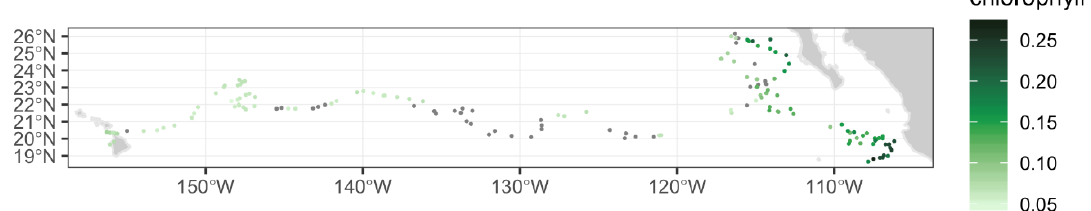
Figure 4. Output graphic from an R script which matches up locations from a tagged fish with satellite chlorophyll data.